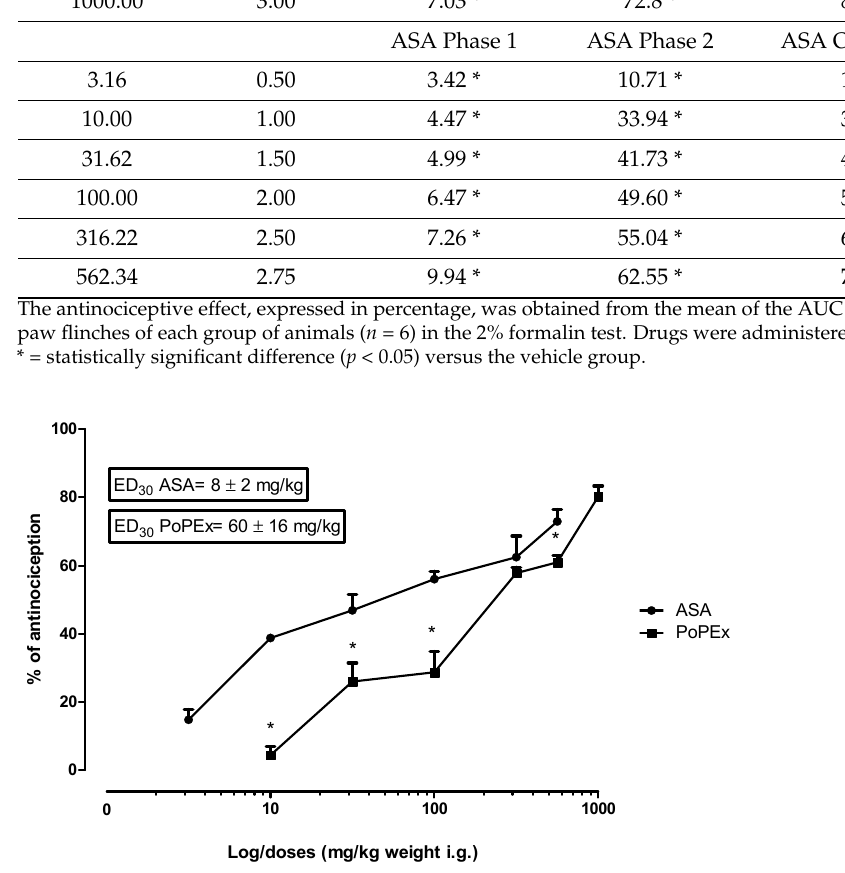
Figure 2. Dose–response curve of PoPEx and ASA. Dose–response curves of the antinociceptive effect of acetylsalicylic acid (ASA) and pomegranate peel extract (PoPEx) from which the ED 30 was obtained. Each point corresponds to the mean ± EE of 6 animals. * = Statistically significant difference versus ASA groups ( p < 0.05).